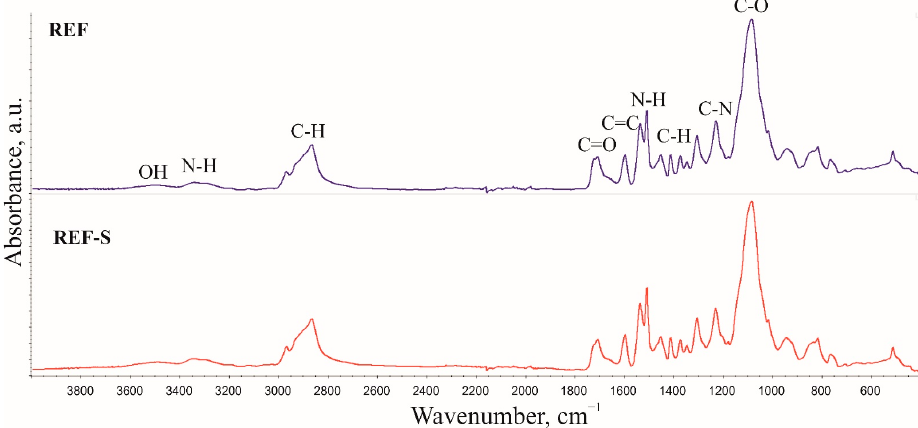
Figure 3. Fourier transform infrared spectroscopy spectra of the reference sample.